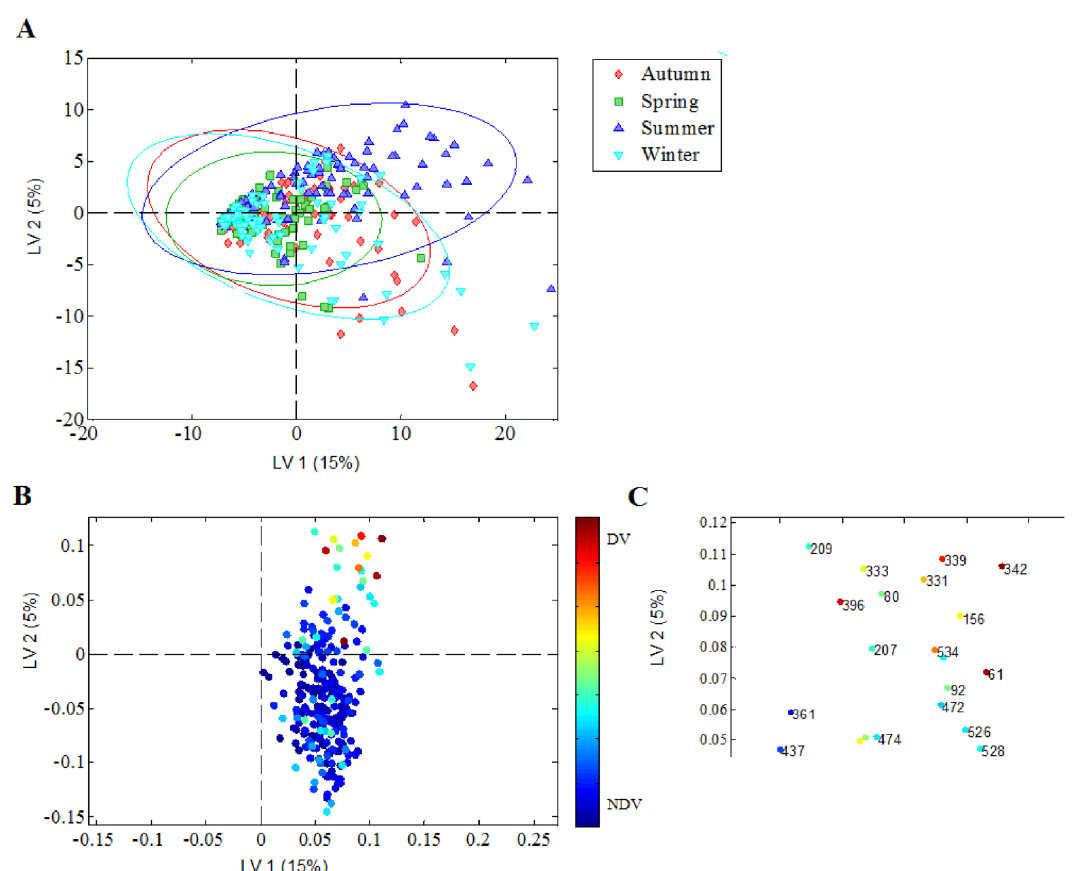
Figure 3. Season of birth-related bacterial richness with a focus on TRFs represented in children born in the summer season. The TRFs were obtained by HhaI cleavage of 16S rRNA gene isolated from nasopharyngeal swab specimens. TRFs profiles were modelled by partial least square regression with season of birth as the discriminatory variable. ( A ) Scores plot. The resulting PLSDA model with two discriminatory latent variables (LVs) explained 20% of the total variation in TRF pattern had a cross-validated sensitivity and specificity of 0.68 ( p permutation,cross-validated < 0.001), and was able to discriminate summer-born children from autumn, winter and spring-born children. Each child is represented by one symbol. Ellipses represent 95% of the class distribution. ( B ) Loadings plot. Each TRF is represented by a dot. TRFs with discriminatory power (DV) and TRFs of non-discriminatory power (NDV) are marked by differing color intensity. ( C ) Zoomed image of loadings plot for TRFs dominant in summer-born children. Identification of TRFs, shown as length in bp, with discriminating power to separate bacterial profiles of summer-born children from autumn, winter and spring-born